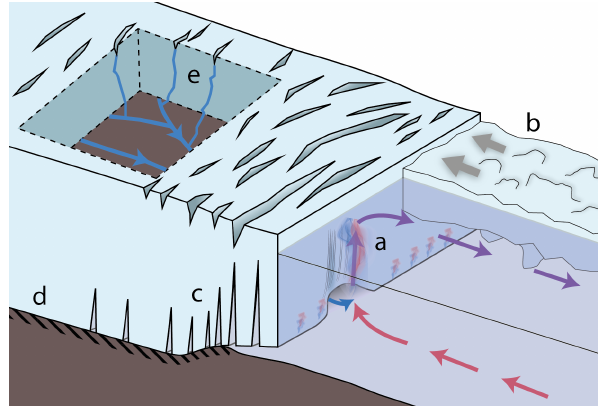
Figure 1. Processes affecting calving of Greenland’s marine- terminating glaciers. (a) Distributed and concentrated plumes ac- celerate melting, which undercuts the ice front. This promotes ex- tensional stress, which opens crevasses at the surface of the glacier. (b) Ice mélange provides buttressing, which supports the terminus and suppresses calving. (c) Basal pinning points and lateral con- strictions inhibit crevasse penetration in the stoss side and enhance it in the lee side. (d) Spatial and temporal changes in basal drag affect stress patterns and crevassing. (e) The basal hydrological sys- tem discharges cold and fresh glacial meltwater, which feeds the plumes that cause high rates of submarine